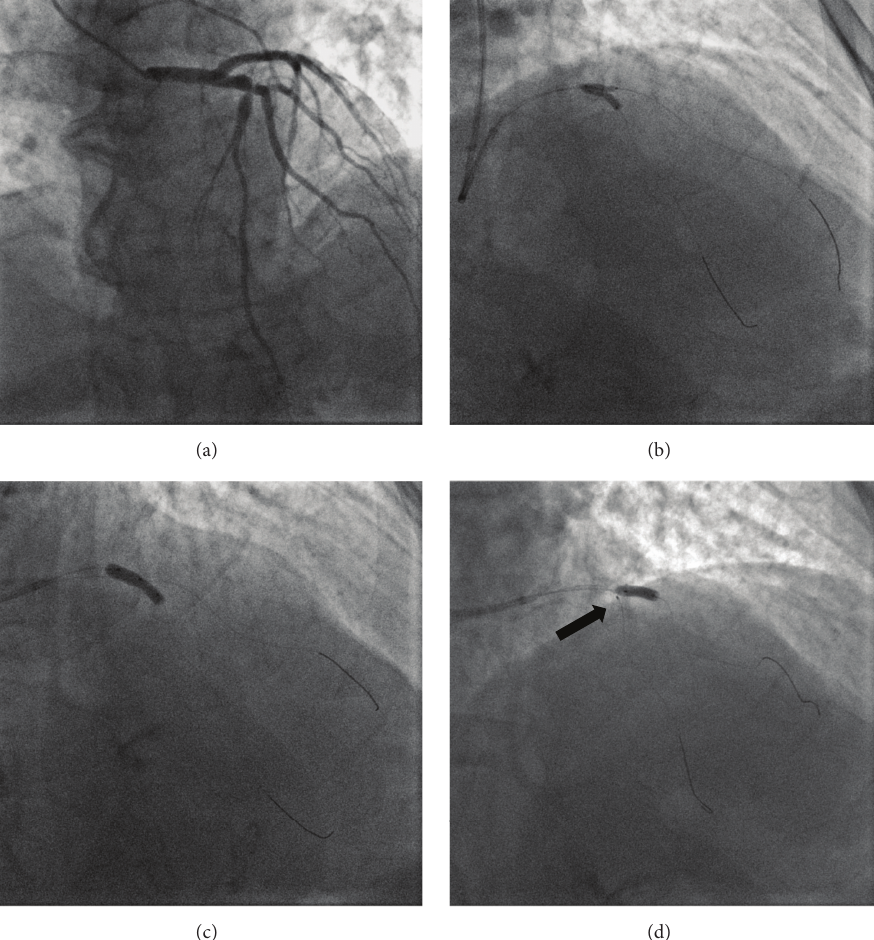
Figure 1: (a) Baseline angiogram. (b) Kissing balloon predilatation. (c) BiOSS Lim sirolimus eluting stent implantation in the proximal-mid left anterior descending artery (main branch). (d) Absorb bioresorbable vascular scaffold implantation in the first diagonal (side branch) with a 1.5mm balloon in the main branch (“sentinel-balloon technique”)